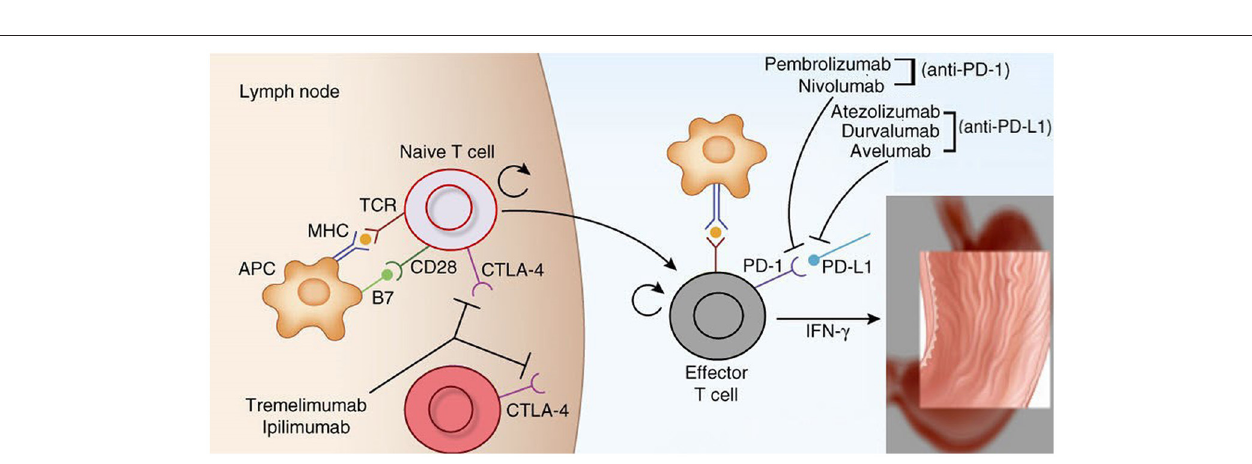
FIGURE 1 | Summary of treatment of advanced stage GC/GEC as recommended by major guidelines (see text).